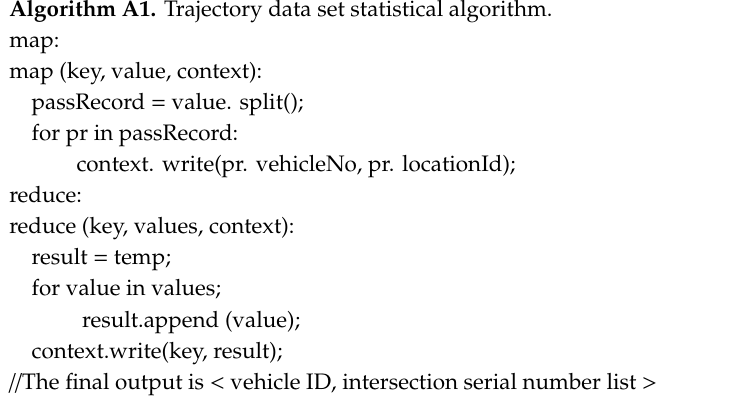
Algorithm A1. Trajectory data set statistical algorithm.